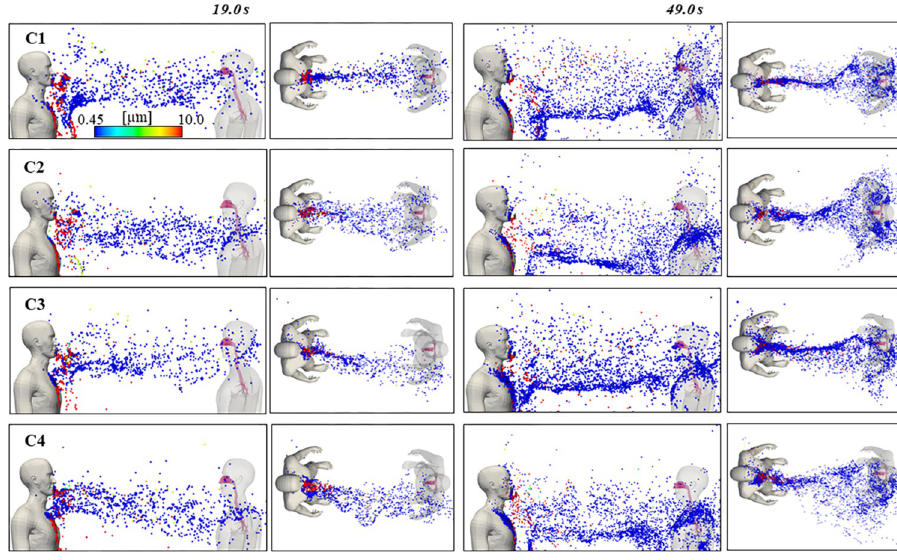
states of particle dispersion are presented in Fig 7 at 19.0 s and 49.0 s, after 10 seconds and 40 seconds of initial particle injection, respectively. Roughly all particles with diameter larger than 20 μ m fall to the ground rapidly within the range of the starting jet due to the effect of gravity. Smaller particles remain airborne and are transported within the consequent train of puffs. Due to the absence of a ventilation current and air motion due to other speakers, the exhaled particles largely reach the face of Human 2 in C1, with a modest angle to the left in the